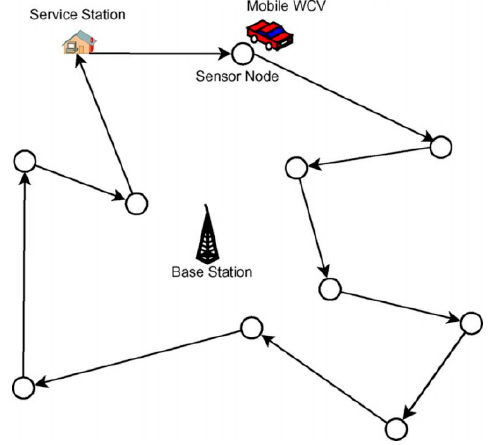
Figure 1. A wireless sensor networks with a wireless charging vehicle (WCV).